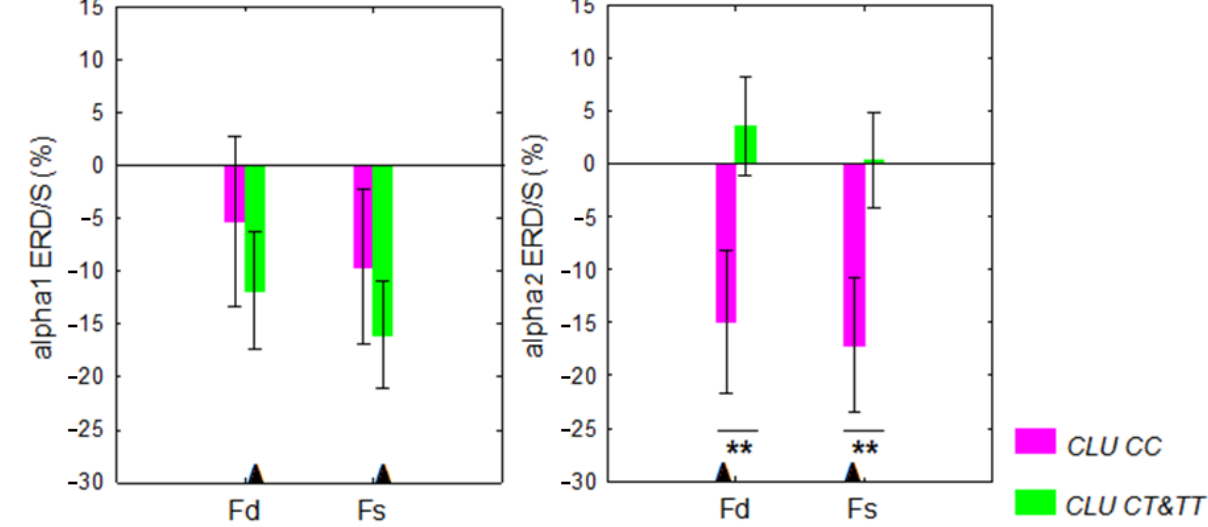
Figure 2. Alpha1 and alpha2 desynchronization/synchronization (ERD/S) in the right (Fd) and left (Fs) frontal regions elicited by the le tt er fl uency test (LFT) in individuals aged 30 to 80 years with di ff erent CLU genotypes. ** p < 0.01, signi fi cant di ff erences in ERD/S between CLU CC and CLU